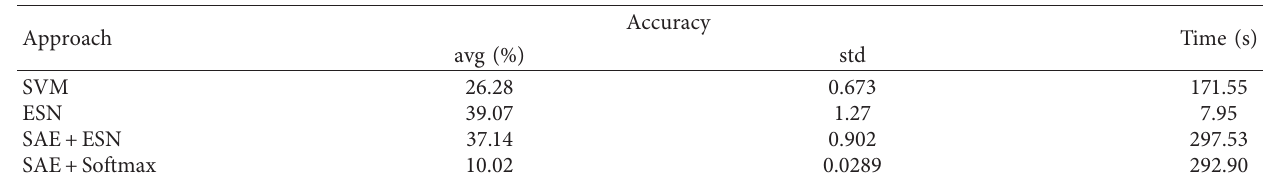
Table 3: Diagnosis results of different approaches.